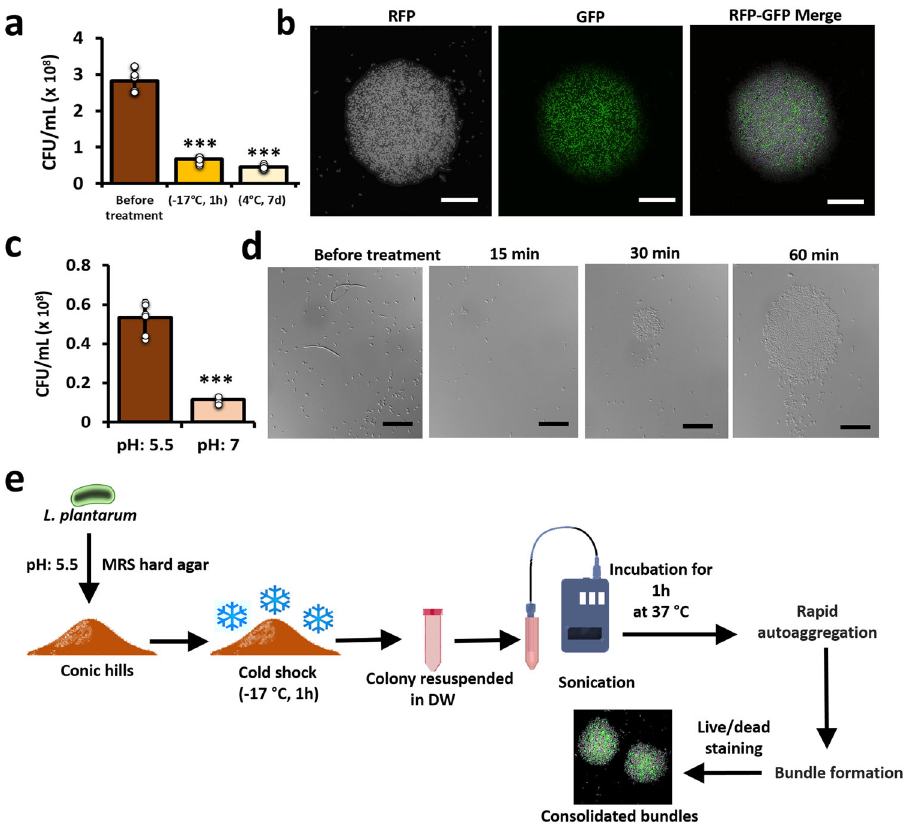
Fig. 2 In fl uence of cold stress on survivability of L. plantarum grown in conic colonies. a The CFU quantitation of L. plantarum 3297 conic colonies following exposure to cold stress. The cells were grown on MRS hard agar (pH 5.5) for 7d and transferred to cold stress conditions ( − 17 °C) for 1 h. After incubation, the colonies were resuspended in phosphate-buffered saline (PBS), vortexed, diluted, and plated on fresh MRS agar plates. Similarly, the colonies were also incubated for 1 week at 4 °C and assessed subsequently. The graph shows the means ± SEMs of 9 individual data points, obtained from three independent measurements. *** P < 0.001 vs. the non-treated controls. b Dual staining (SYTO ™ and propidium iodide (PI)) of consolidated bundles that was induced following frozen stress ( − 17 °C, 1 h). Scale bar: 20 µm. The cells stained with PI (true-colour: red) are false-coloured with grey. c The CFU quantitation of L. plantarum 3297 conic colonies following exposure to frozen stress. The cells were grown on MRS hard agar pH 5.5 or 7 for 7d and transferred to cold conditions ( − 17 °C) for 1 h. After incubation, the colonies were resuspended in phosphate-buffered saline (PBS), vortexed, diluted, and plated on fresh MRS agar plates. The graph shows the means ± SEMs of 9 individual data points, obtained from three independent measurements. *** P < 0.001 vs. the non-treated controls. d Time-course analysis of cellular aggregation of L. plantarum 3297 cells from conic colonies to form consolidated bundles (within 1 h). Scale bar: 20 µm. e Schematic experimental setup that led to the sighting of consolidated bundles. The cells stained with PI (true-colour: red) are false-coloured with